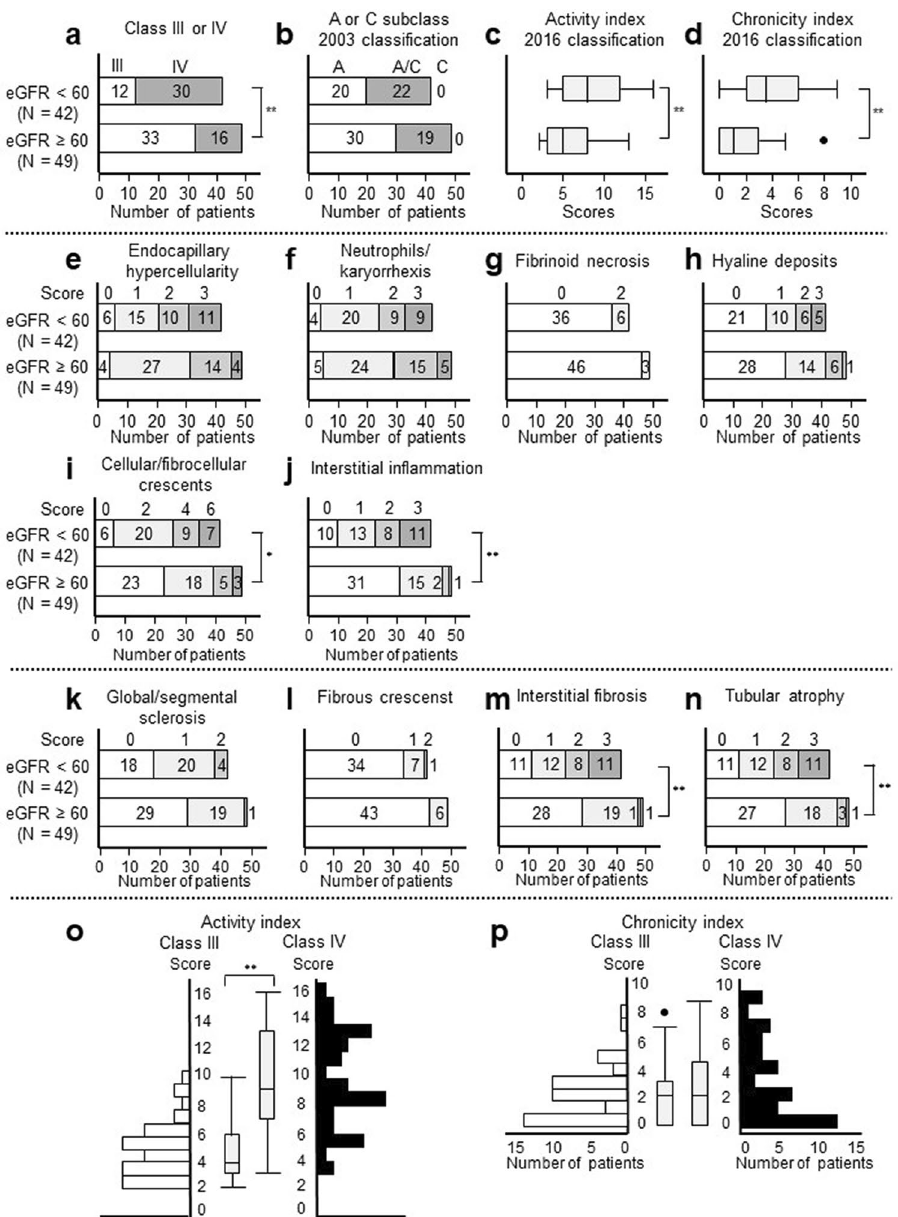
Figure 2. Pathological findings according to the 2003/2016 classification. Baseline pathological findings are described according to the baseline eGFR levels (eGFR < 60 ml/min/1.73 m 2 , n = 42 and eGFR ≥ 60 ml/ min/1.73 m 2 , n = 49). ( a , b ) are based on the 2003 classification: class III or IV ( a ) and subclass of A, C, and A/C ( b ). ( c , d ) are based on the 2016 classification: activity index ( c ) and chronicity index ( d ). ( e – j ) represent the following pathological components of activity index in the 2016 classification: endocapillary hypercellularity ( e ), neutrophils/karyorrhexis ( f ), fibrinoid necrosis ( g ), hyaline deposits ( h ), cellular/fibrocellular crescents ( i ), and interstitial inflammation ( j ). ( k – n ) represent chronicity index in the 2016 classification: global/segmental sclerosis ( k ), fibrous crescents ( l ), interstitial fibrosis ( m ), and tubular atrophy ( n ). ( o , p ) are distributions of activity index ( o ) and chronicity index ( p ) in patients with class III and IV LN, respectively. N number, eGFR estimated glomerular filtration rate, LN lupus nephritis. * p < 0.01. ** p <